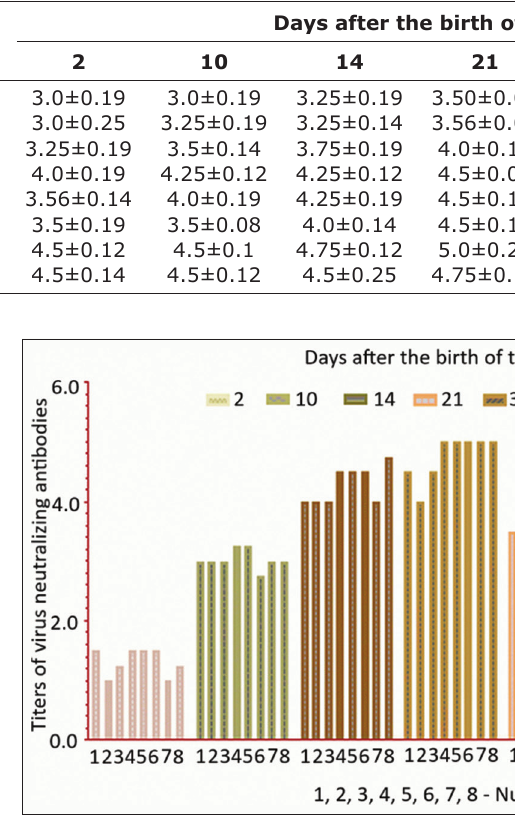
Figure-5: Dynamics of the formation of colostral immunity in